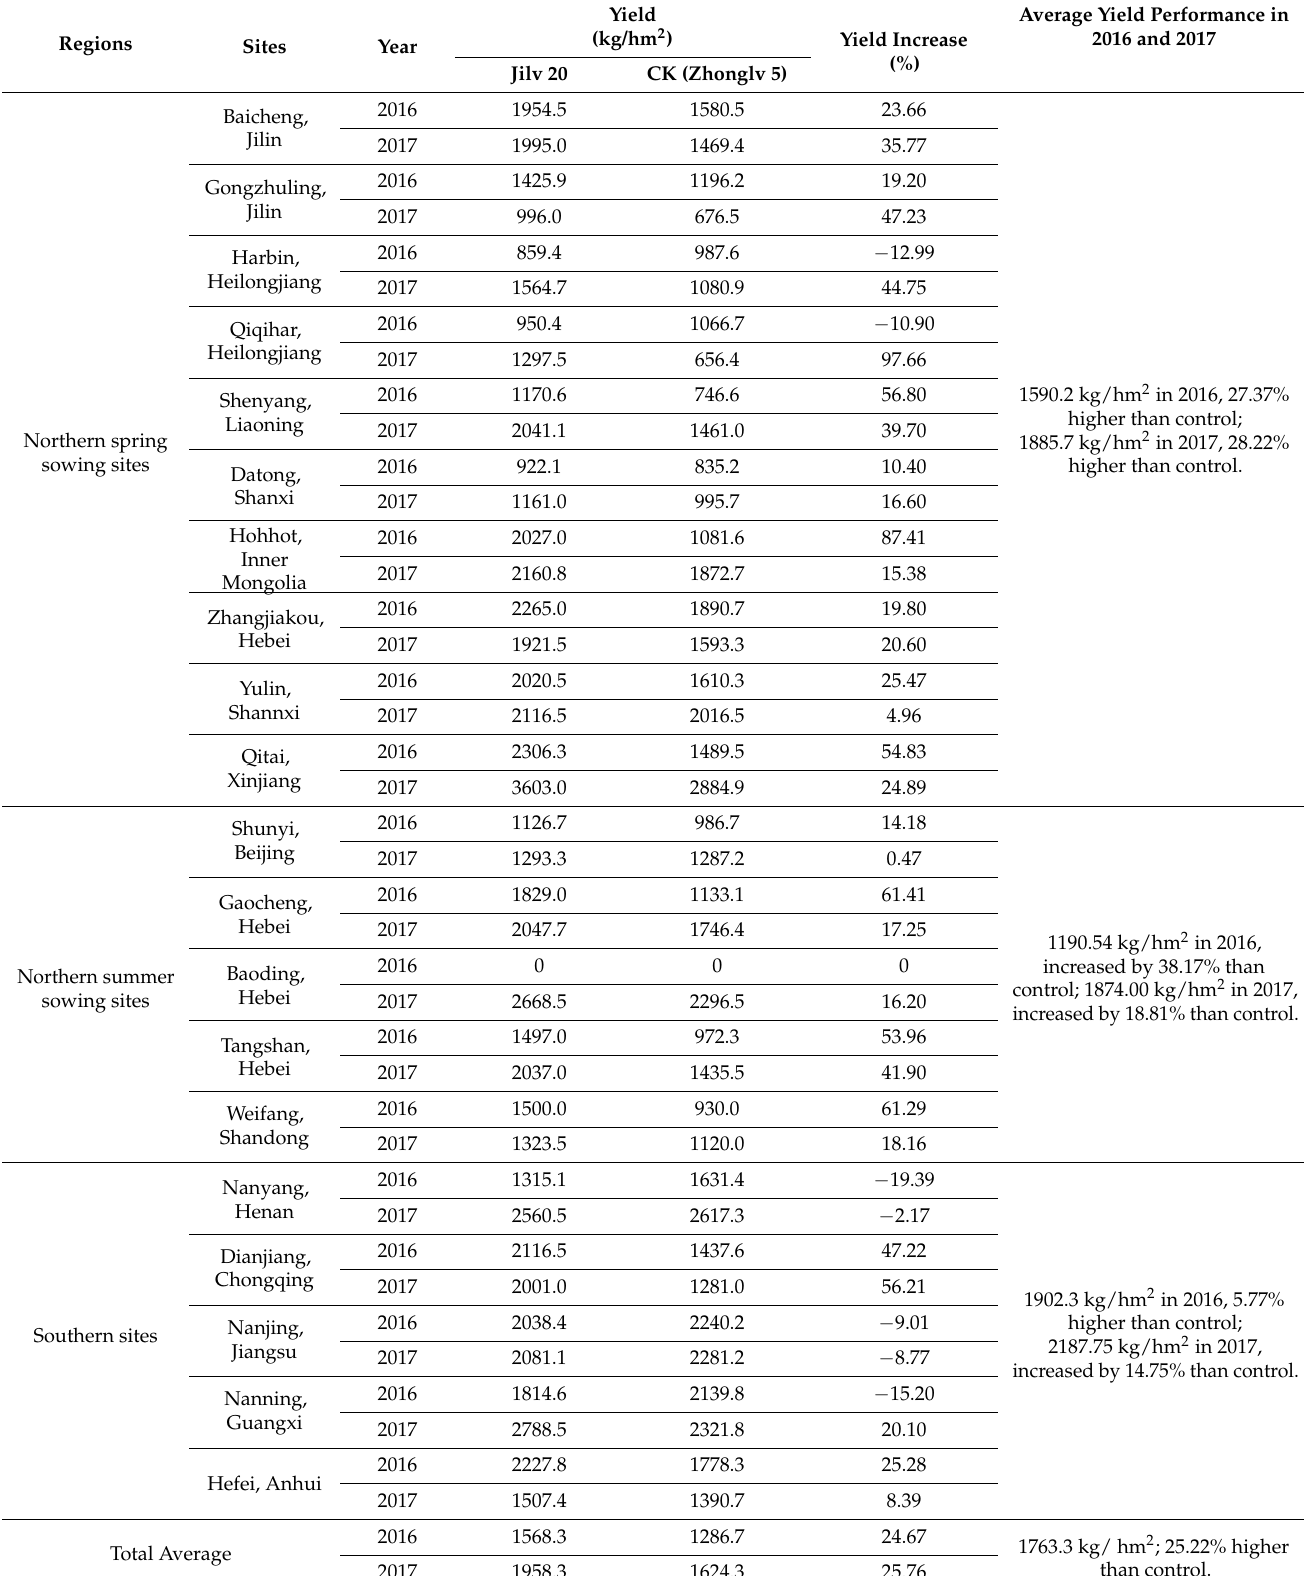
Table 7. Yield performance of Jilv 20 in multi-ecological identification trials in 2016 and